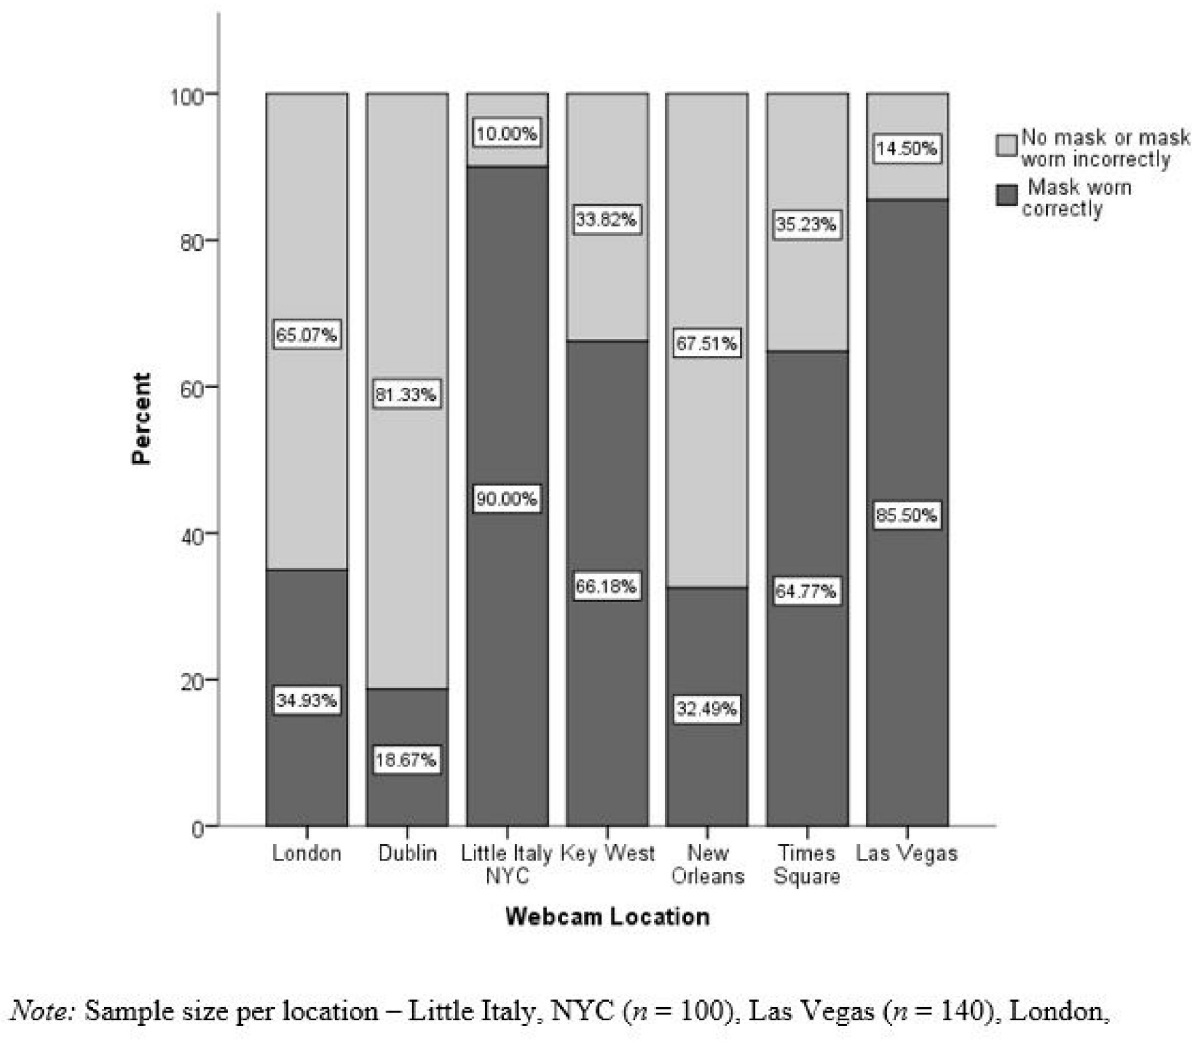
Fig 2. Mask-wearing by